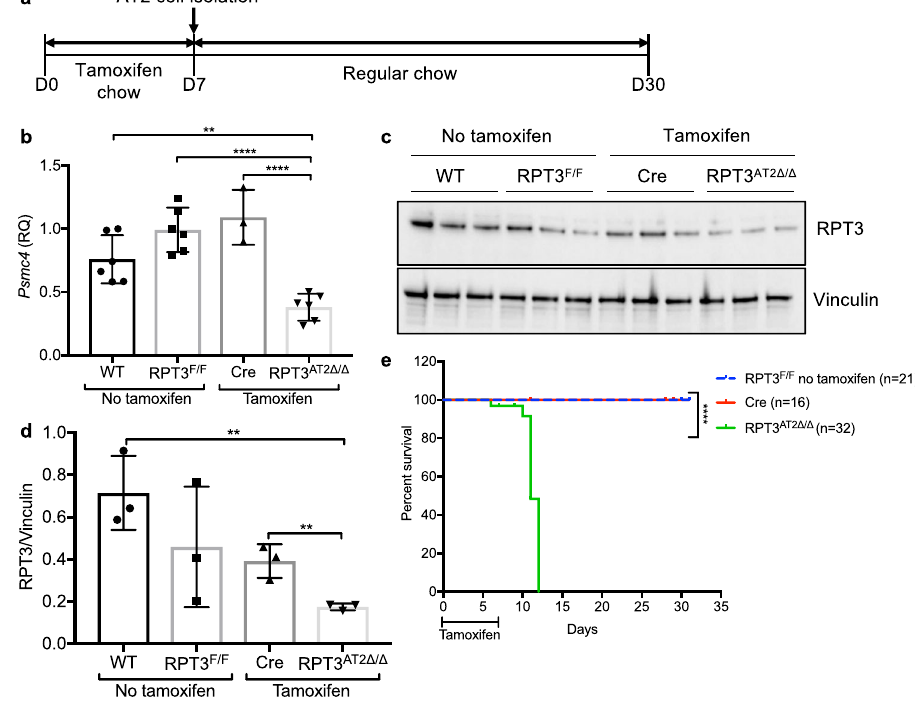
Figure 1. Targeted deletion of RPT3 in AT2 cells is lethal. ( a ) Sftpc WT/CreER :RPT3 F/F (RPT3 F/F ) and Sftpc WT/CreER (Cre) mice were fed tamoxifen chow for 7 days to promote recombination at the Psmc4 (RPT3) locus in AT2 cells, then switched to regular chow on day 7. The efficiency of recombination was assessed in AT2 cells (isolated on day 7) by quantitative PCR ( b ) and Western blotting ( c ). ( d ) Densitometry of Western blot in c. ** p < 0.01,